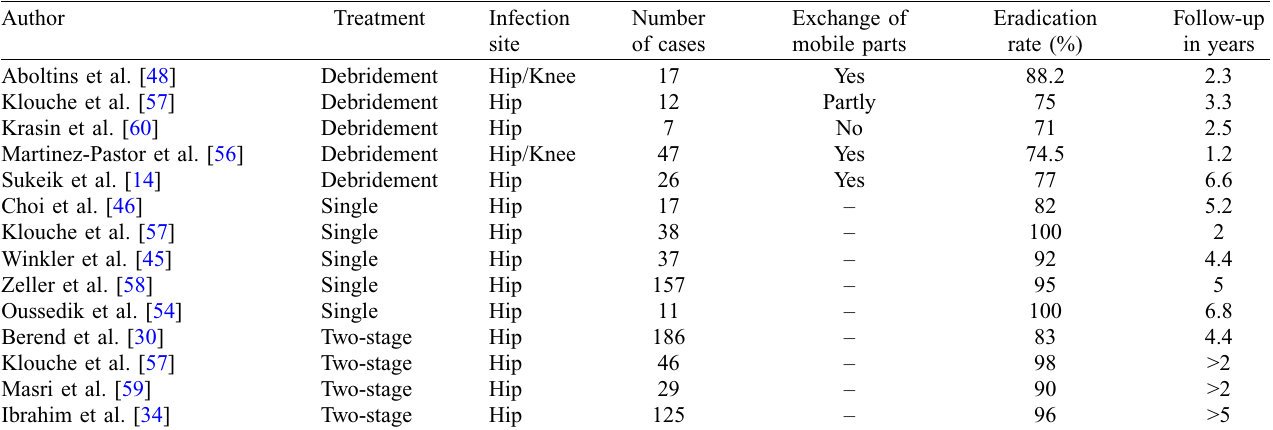
Table 1. Previous studies reporting PJI eradication rates following various treatment